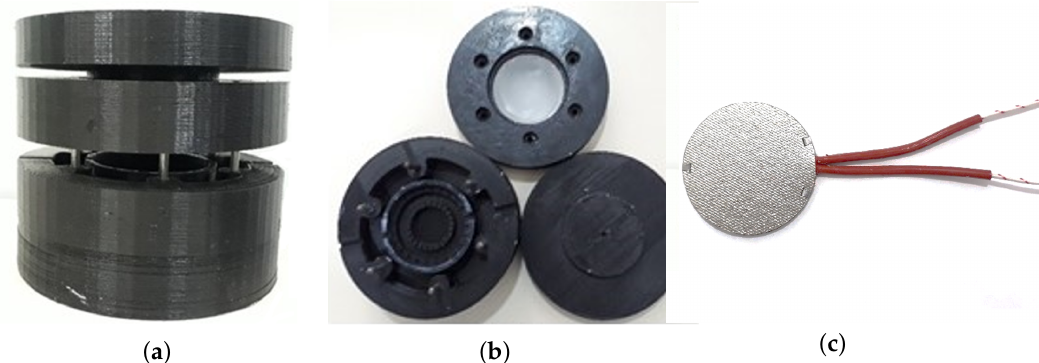
Figure 10. Elements for the implementation of the T-melting CHF method. ( a ) Device assembly; ( b ) top view of base, frame, and Cap; ( c ) electric heating resistance.